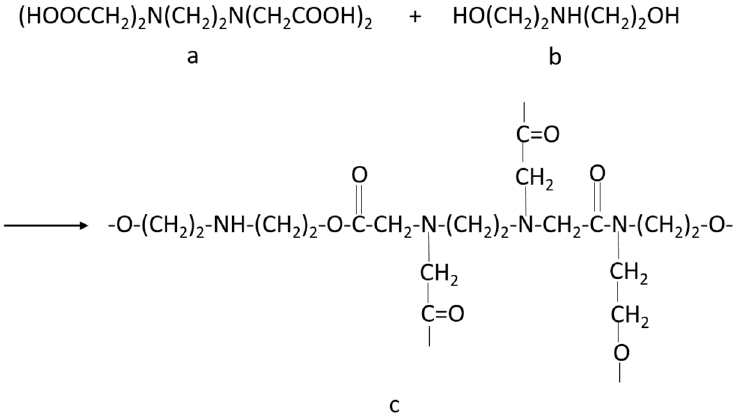
Figure 1. Molecular structure of ethylenediaminetetraacetic acid (EDTA) ( a ), diethanolamine (DEA). ( b ) and possible fragments of poly(ethylenediaminetetraacetic acid-diethanolamine) (PEDTA-DEA) ( c